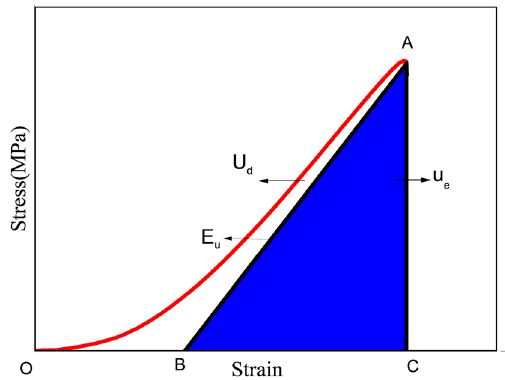
Figure 7. In stress–strain curve, analysis of the relationship between dissipation strain energy and elastic strain